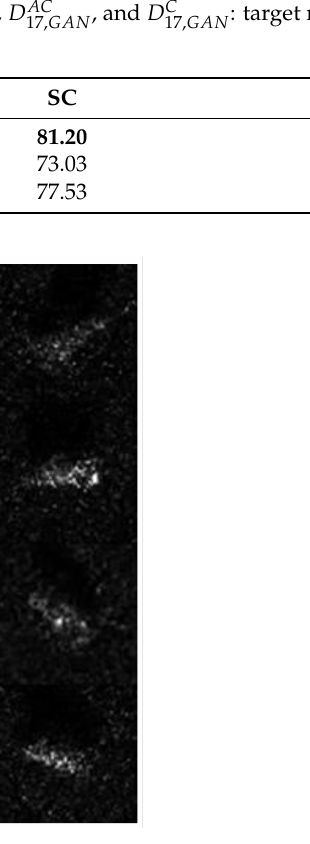
Figure 8. The 16 “BMP2”-class SAR images generated by ACGAN m . It should be noted that the generator of ACGAN m generated SAR target images at random pose angles with the same number of SAR target images per each class corresponding to D 17